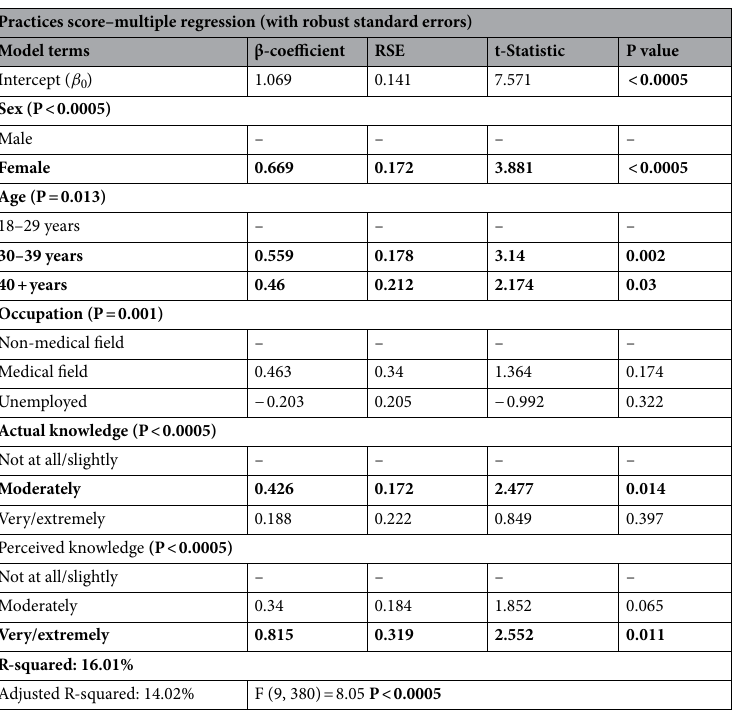
Table 4. Multiple linear regression models - Practices. The table represents the results of the practices multiple linear regression models. P values that are significant at the 5% level are bolded. The significance level of the bivariate analyses is displayed under each predictor. This reflects the P value for the corresponding test with respect to the outcome variable (Mann–Whitney U for binary predictor variables, or Kruskal–Wallis for those with more than two groups). Robust Standard errors were used with an HC1 estimator. The model contains every significant predictor. RSE robust standard errors, HAV Hepatitis A